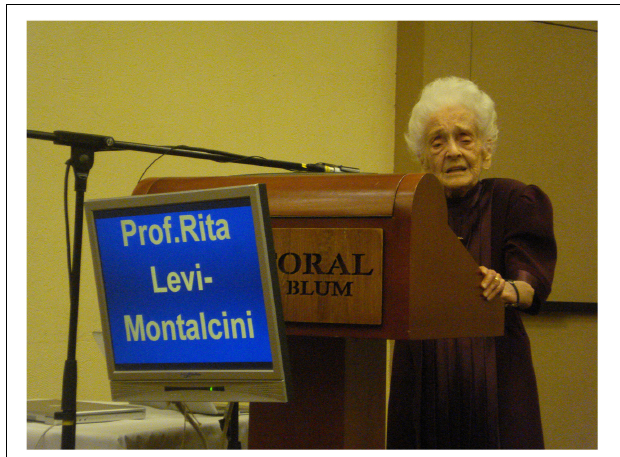
FIGURE 4 | Rita Levi-Montalcini during her talk at the International NGF meeting, in Israel, 2008 [Photographer Annalisa Manca (EBRI) from EBRI Media